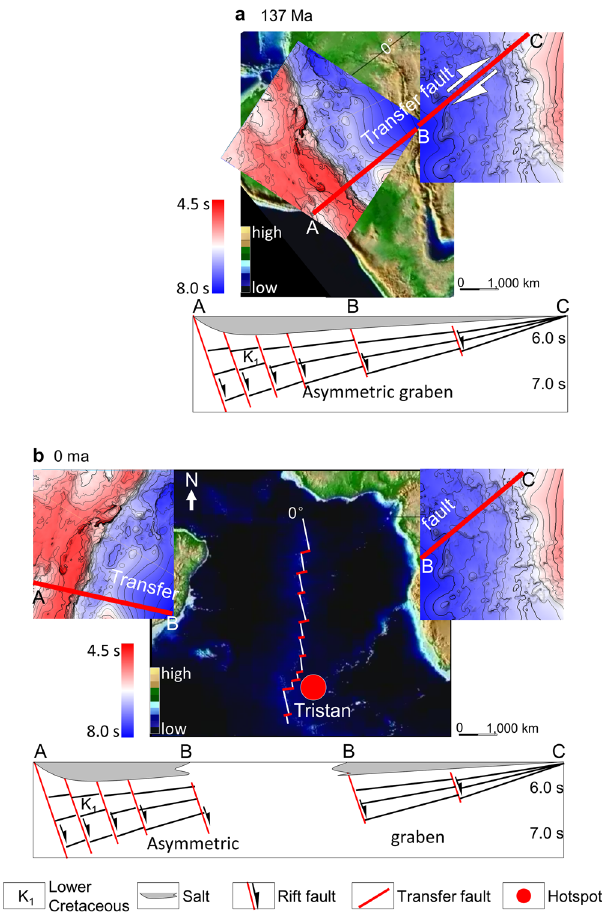
Fig. 3 An asymmetric graben and a transfer fault that split and drifted apart due to South Atlantic opening. The two contour maps are close-up views of the basement top derived from 3D seismic surveys at the Brazilian and the Angolan margins, respectively. a Pre-drift con fi guration of an asymmetric graben and a transfer fault. b Present-day con fi guration of the graben and the transfer